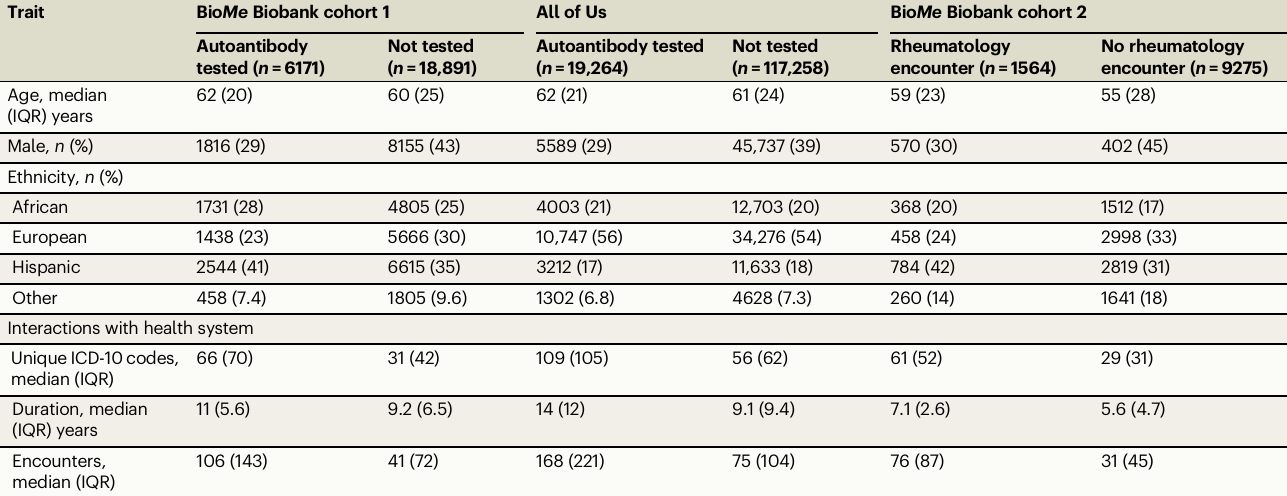
Table 1 | Summary of participant demographics and health system